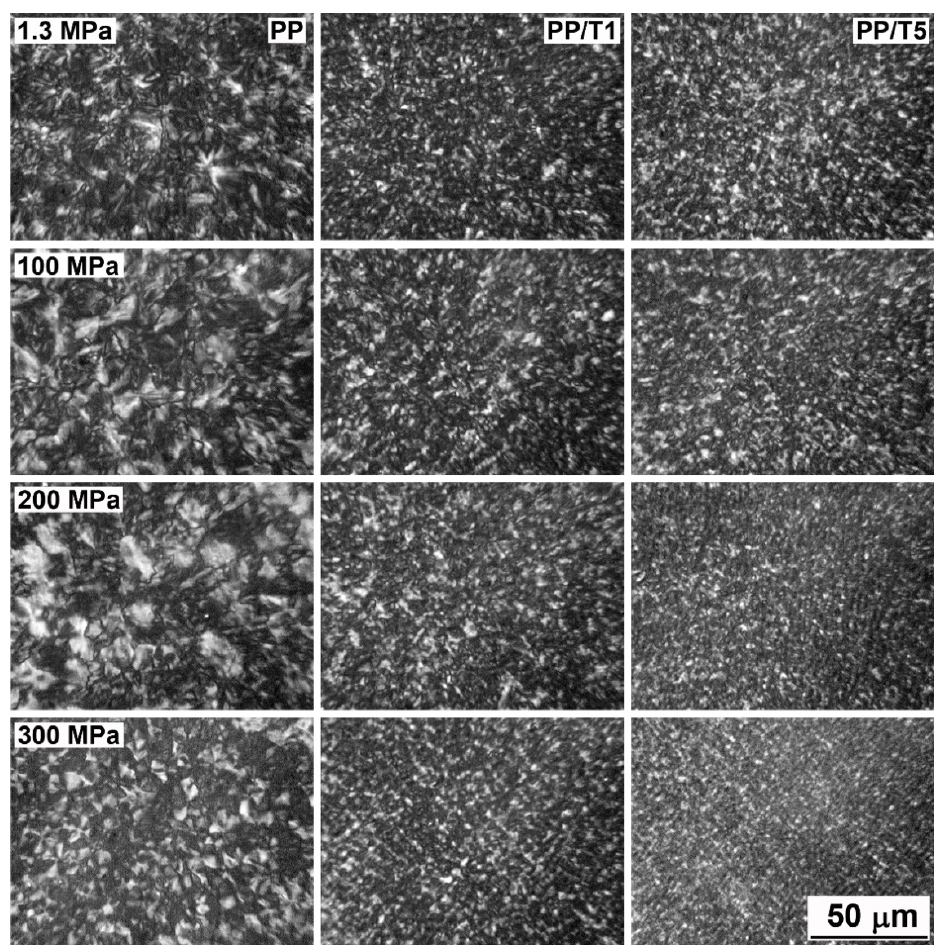
Figure 4. Crystallization temperatures, T c , of neat PP and PP/T nanocomposites crystallized during cooling under various pressures.